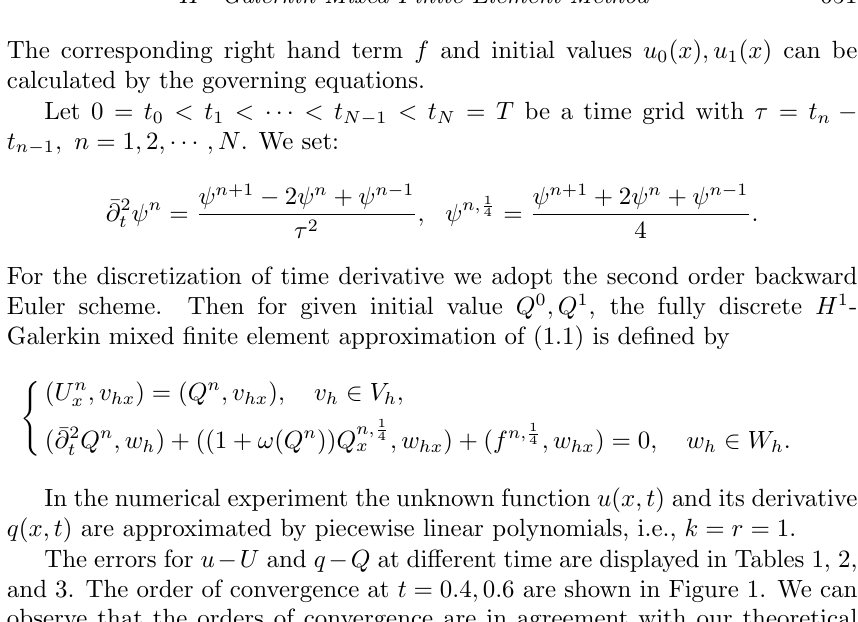
Table 1. The errors of (cid:107) u n − U n h = ∆t t = 0 . 2 t = 0 . 4